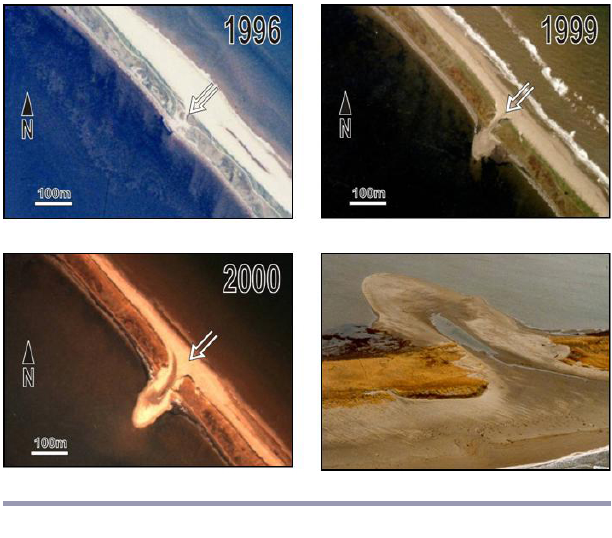
Fig. 2 . Aerial photographs showing the evolution of the breach in the middle section of the Bouctouche Dune (site BOUC) from 1996 to 2000. Presence of a notch created by off-road vehicles in the dune front (1996), breach and storm delta developed at the same location (1999), and breach and storm delta as enlarged by the 29 October 2000 storm (2000). The lower right-hand photograph shows the same breach and storm delta in 2000 from an oblique view. 1996, Service New Brunswick 46506460. 1999 and 2000, Irving Eco-Center-la Dune de Bouctouche private series. Such breaches appear to result in higher productivity in Piping Plover ( Charadrius melodus melodus ) populations (see text).